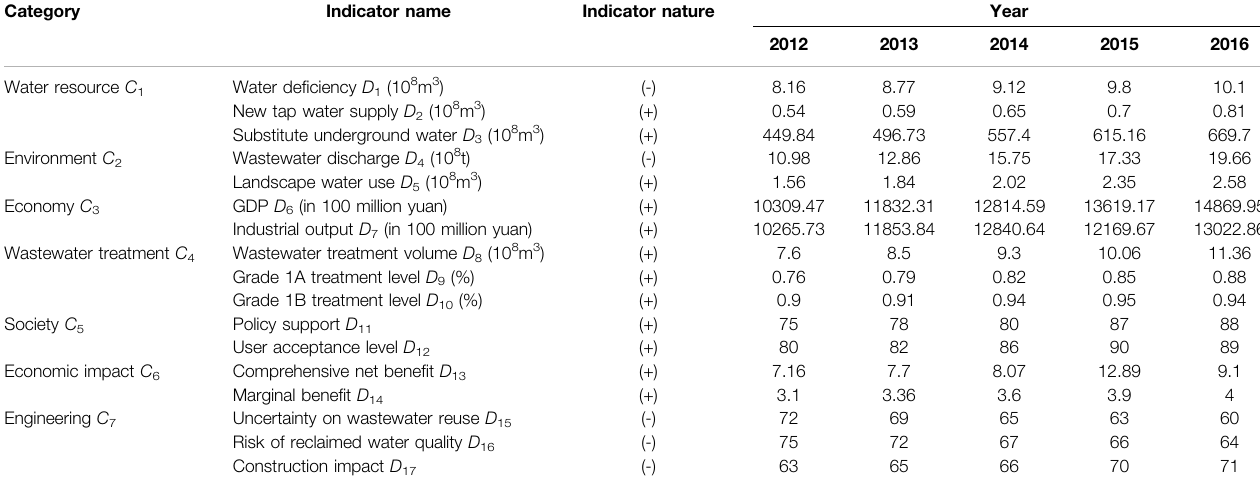
TABLE 2 | Indicators for assessing comprehensive development level of reclaimed water. Category